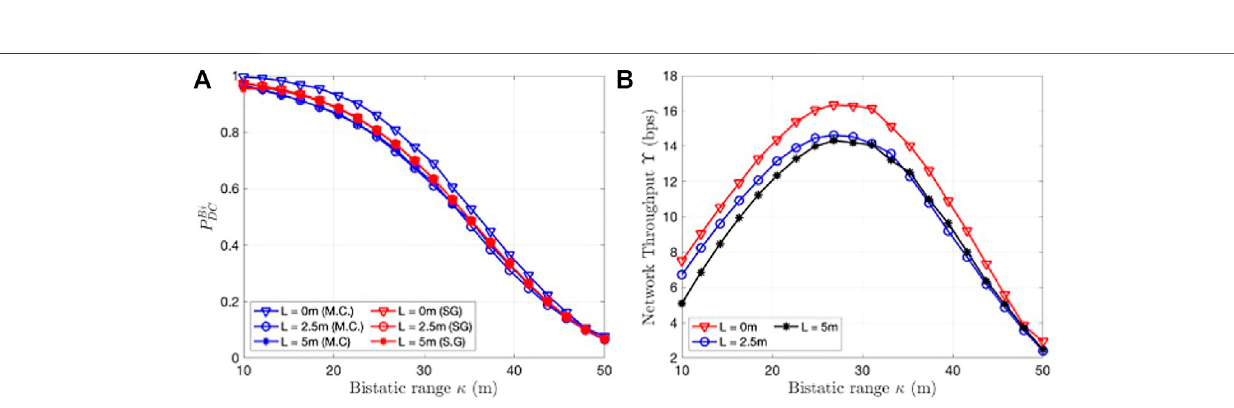
FIGURE 8 | (A) Detection coverage ( P Bi DC ) and (B) network throughput ( ϒ ) as a function of target bistatic range ( κ m ) for parametric bistatic base length ( L ).